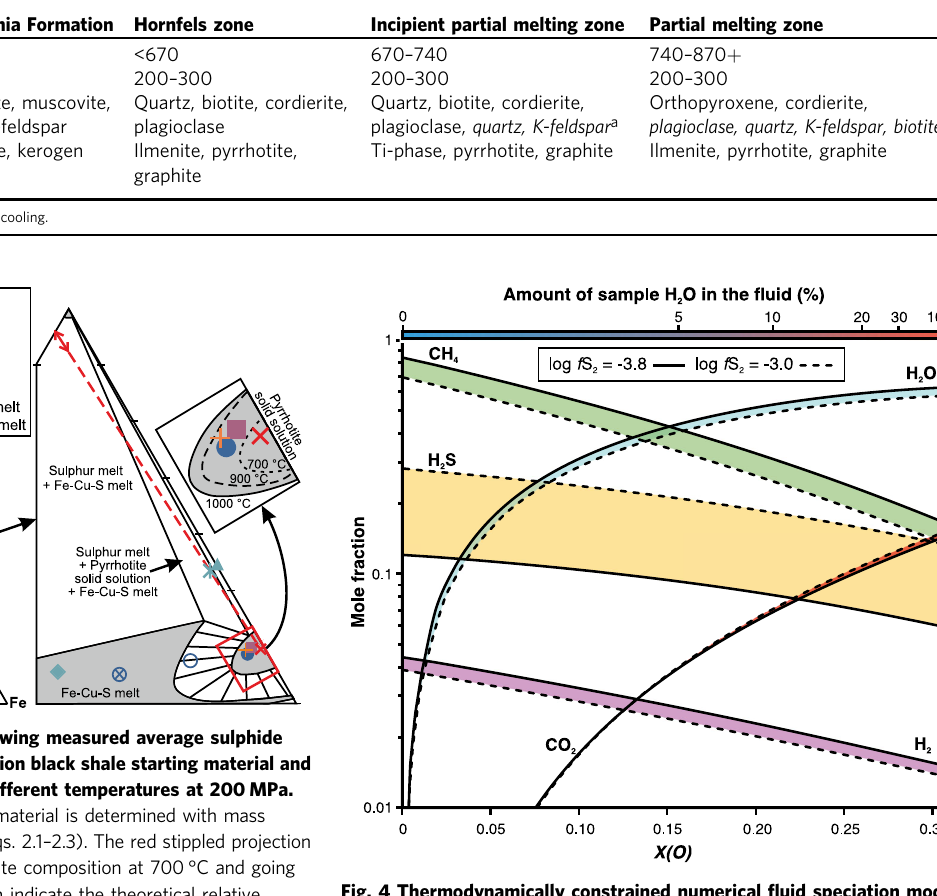
Fig. 4 Thermodynamically constrained numerical fl uid speciation model for the black shale heating experiment at 700 °C, 200 MPa. Mole fraction of each fl uid species is shown on the y -axis on a logarithmic scale and the x - axis variable X(O) is de fi ned by the molecular O/(O + H) of the fl uid. The amount of sample H 2 O in the fl uid approximates the degree of dehydration and is calculated by adding H 2 O to the H kerogen . The model was constructed with the FLUIDS protocol of the PerpleX software (version 6.8.9 47 ) using the modi fi ed Redlich-Kwong hybrid equation of state for COHS- fl uids 48 . Oxygen fugacity is buffered by graphite and the sulphur fugacities were approximated using the methods of Toulmin and Barton 44 and Mengason et al. 45